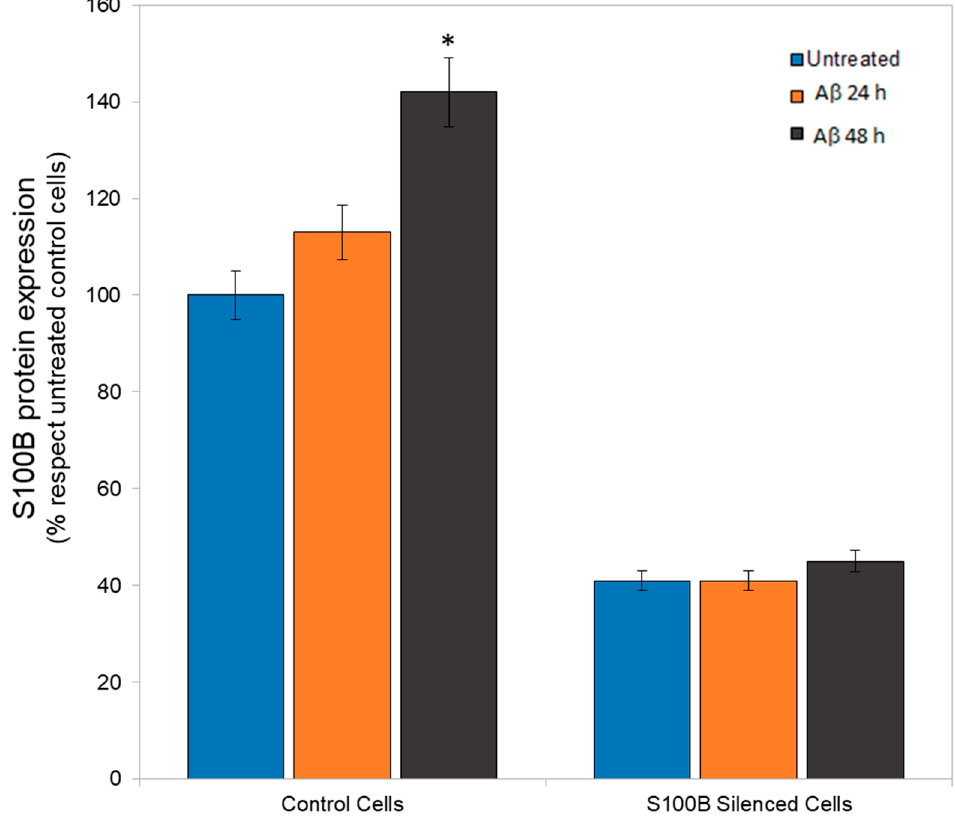
Figure 2. S100B protein levels in control and S100B-silenced cells, after treatment with 10 µ M A β for 24 h (orange bars) and 48 h (black bars), or in the absence of A β (blue bars). Percentage values were obtained as indicated in the Materials and Methods section, and expressed as % in respect to the untreated control cells (100%). * p < 0.05 treated vs. untreated. The values of S100B expressed as ng/mL (respectively for control and silenced cells) were 10.41 vs. 3.8 (untreated), 11.8 vs. 3.7, (A β 24 h) and 15.00 vs. 3.9 (A β 48 h).